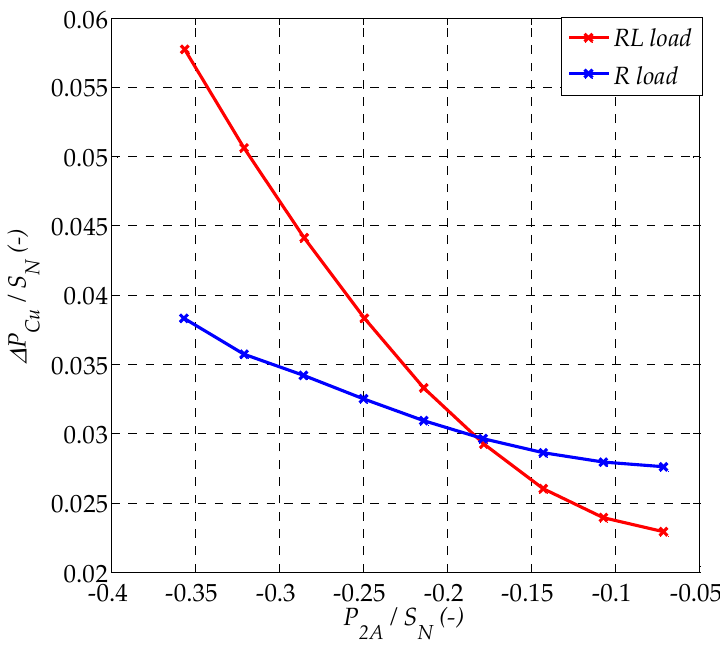
Figure 14. Load losses of the transformer with amplitude–phase control of active powers P 2A , P 1A .